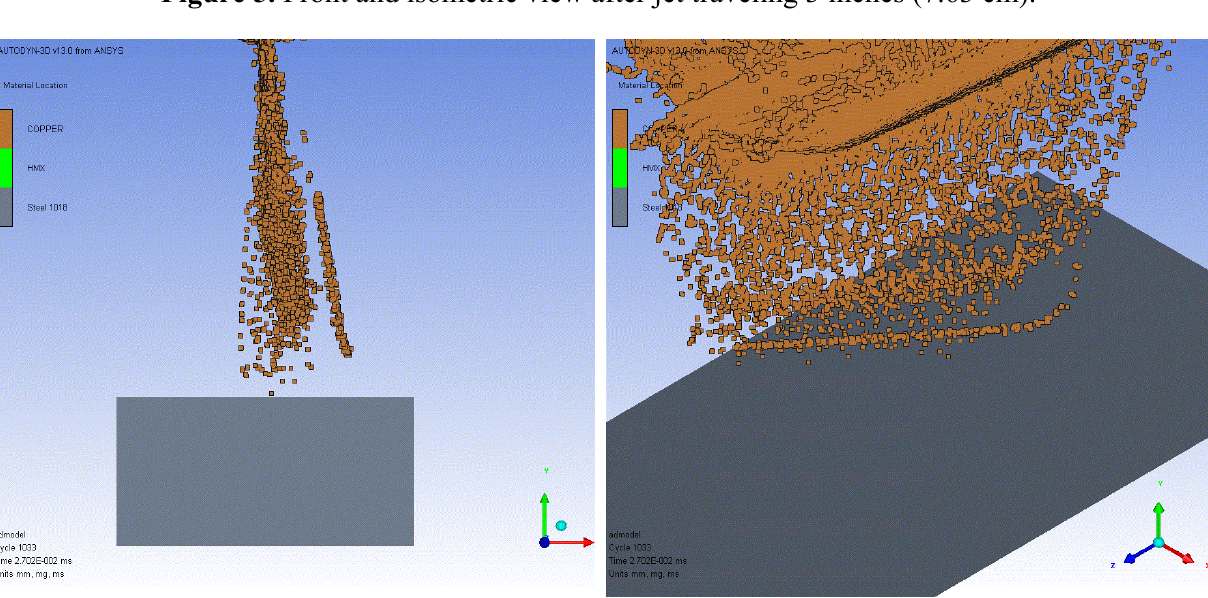
Figure 5. Front and isometric view after jet traveling 3 inches (7.63 cm).